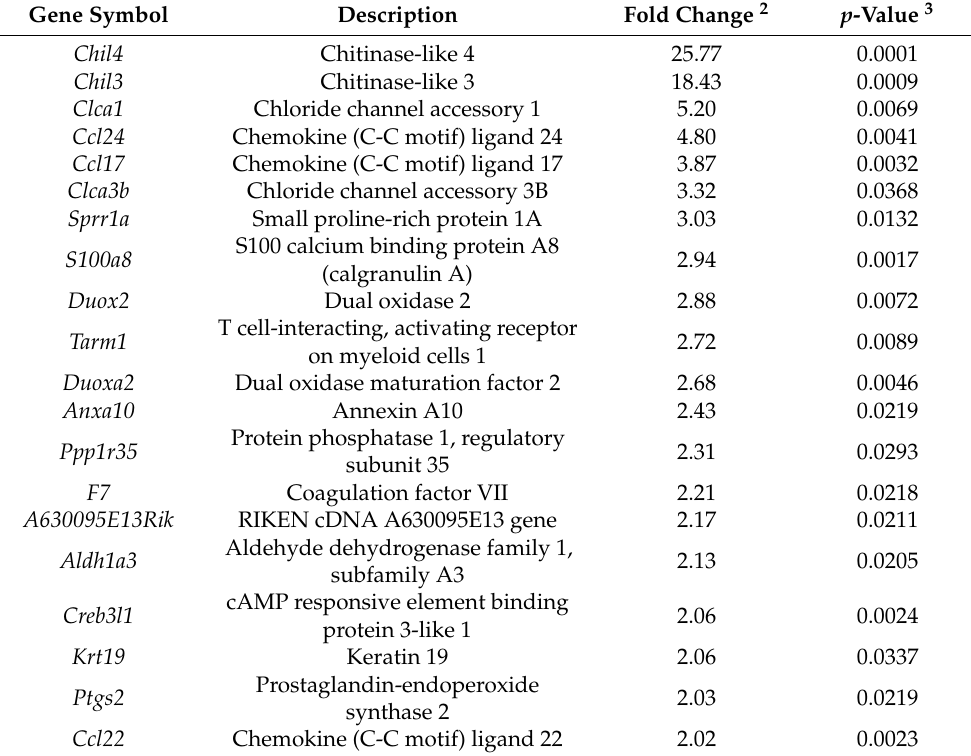
Table 1. Profile of upregulated genes in pancreatic tumors of mice treated with fucoxanthin (Fx) 1 .